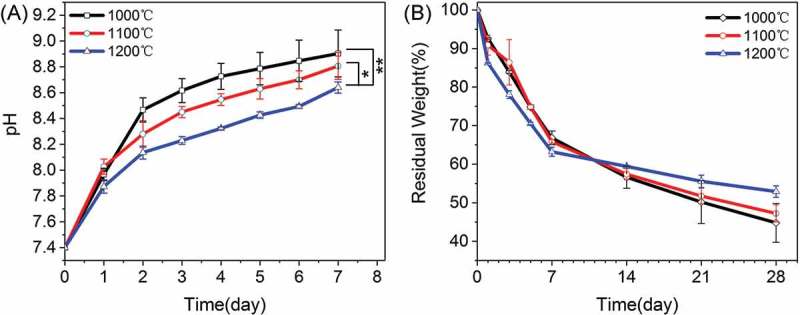
(A) pH values and (B) in vitro degradation of β-Ca2SiO4 scaffolds sintered at different temperatures in SBF (n = 3; * and ** indicate significant differences, p < 0.05 and p < 0.01).